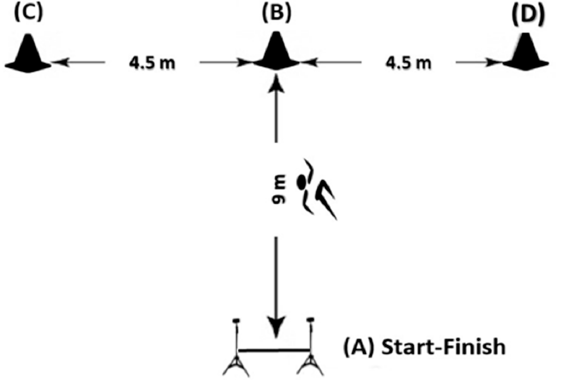
Figure 2. T-drill test. Figure 2. T ‐ drill test. Figure 2. T ‐ drill test.